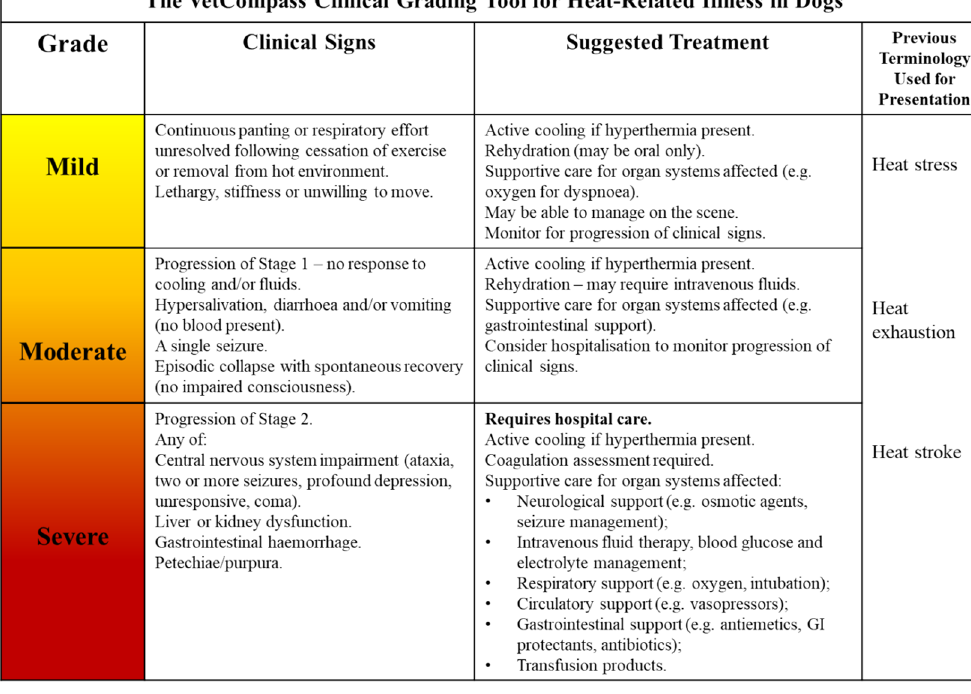
Figure 3. The novel VetCompass clinical grading tool for heat-related illness in